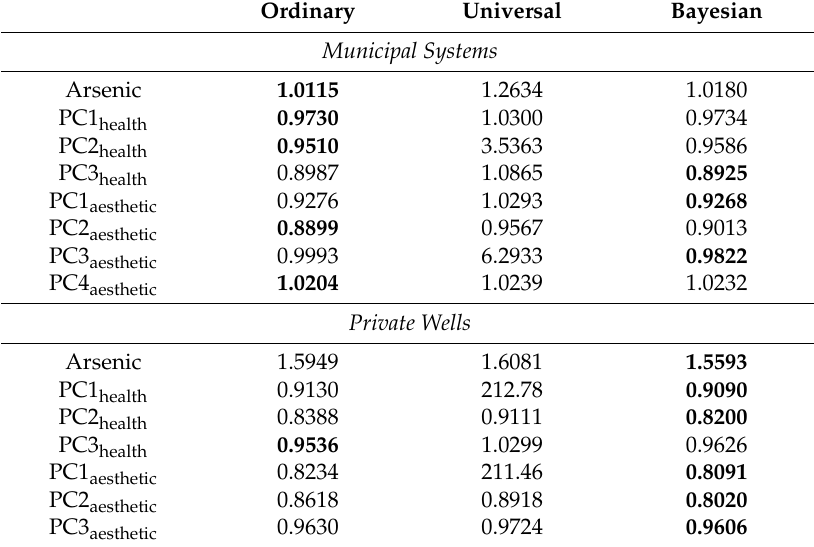
Table 6. Root mean square error values for each parameter obtained from cross validation analysis of ordinary, universal and empirical Bayesian kriging models for public water supply and private well data. The lowest RMSE for each variable is bolded.